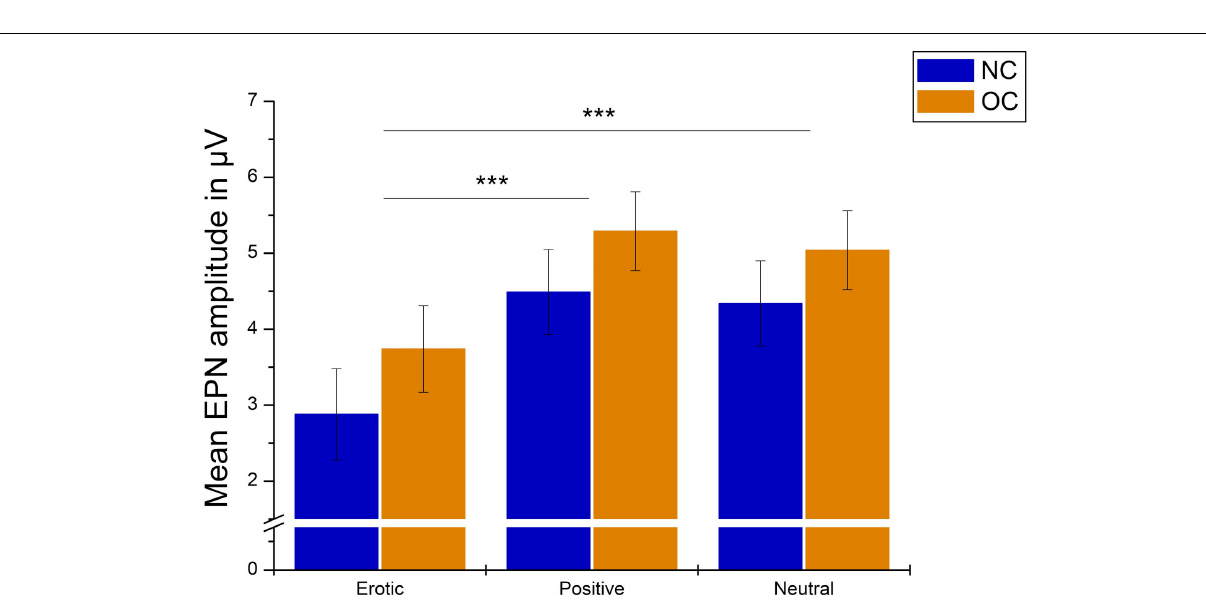
Frontiers in Neuroscience |